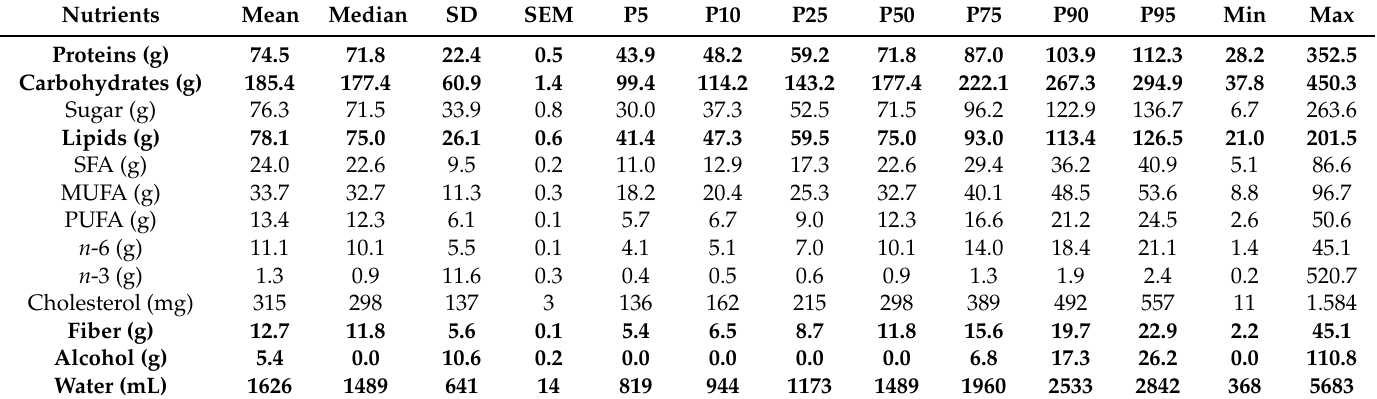
Table 1. Daily nutrient intake and distribution in the Spanish ANIBES study population (9–75 years